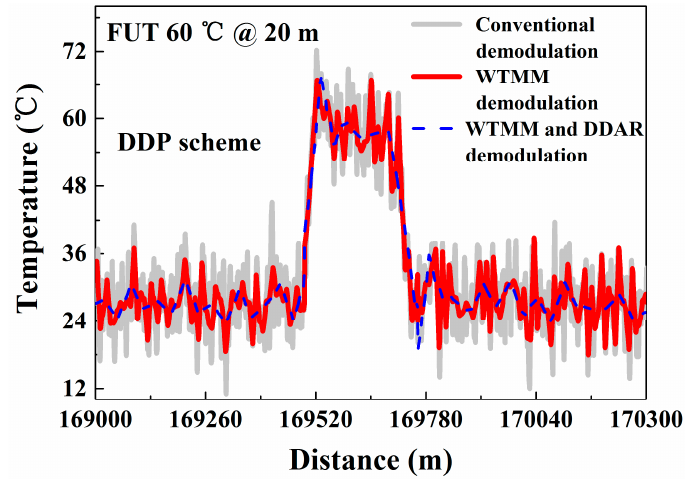
Figure 7. Temperature measurement results of FUT.